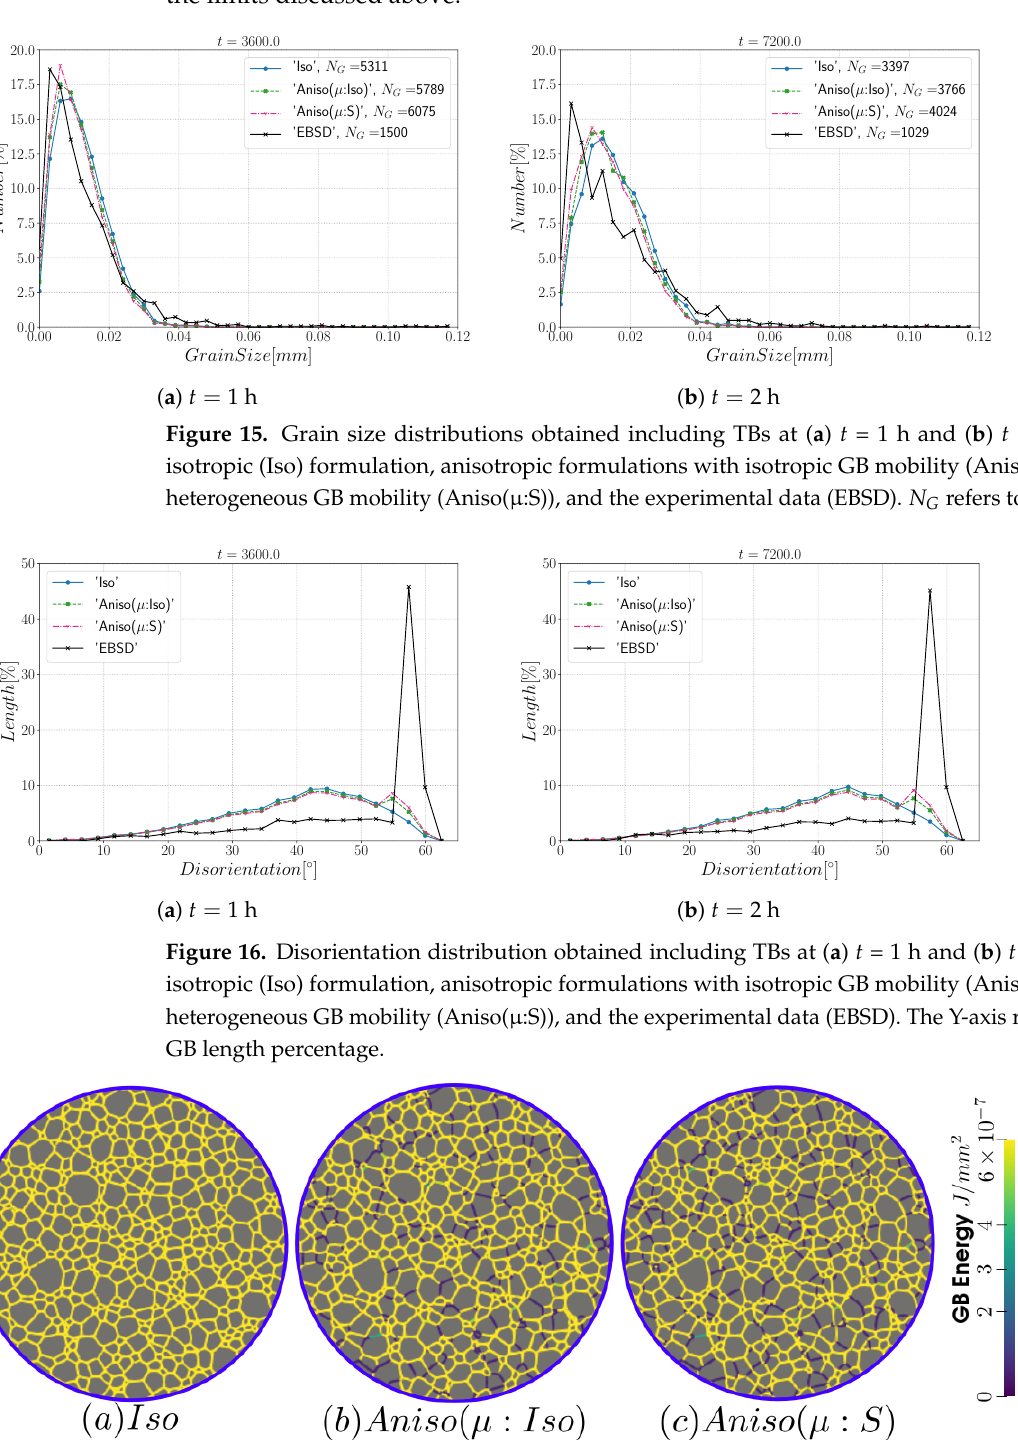
Figure 17. GB energy of the microstructure obtained with the ( a ) isotropic and anisotropic formula- tions using ( b ) isotropic GB mobility and ( c ) heterogeneous GB mobility at t = 2 h in the same zone shown in Figure